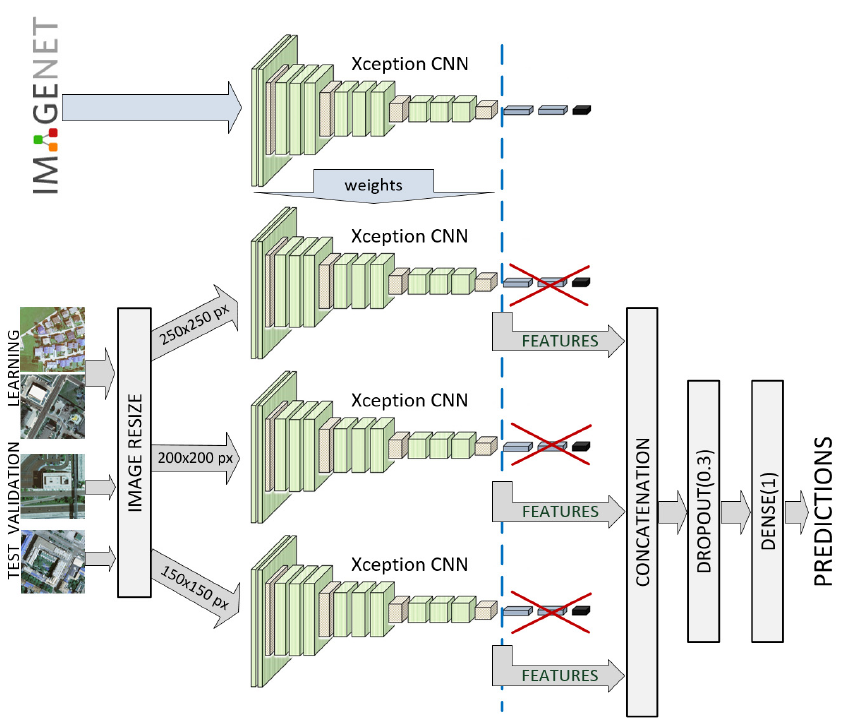
Figure 8. Deep ensemble model for regression—3 x Xception.